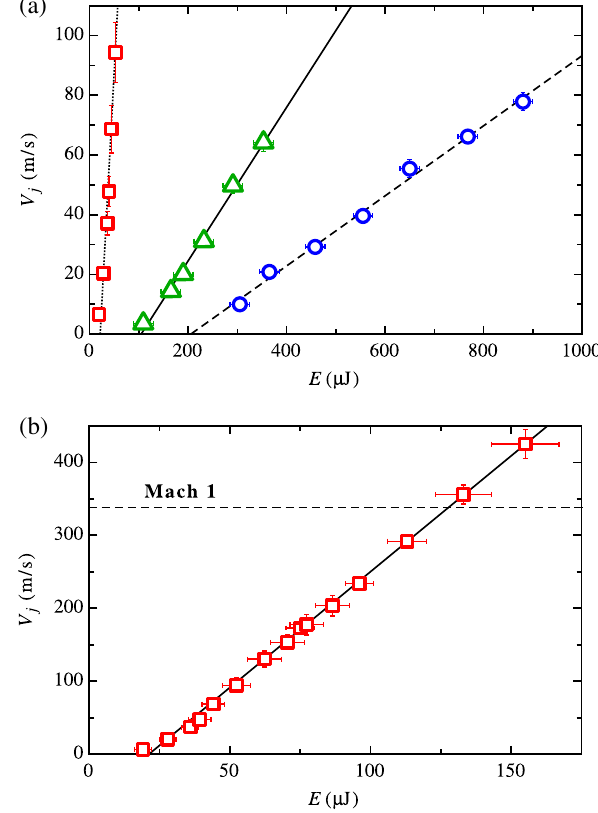
FIG. 8. (a) Asymptotic jet velocity V as a function of the j energy absorbed by the liquid in the capillary tubes. The squares ( h ), triangles ( 4 ) and circles ( (cid:7) ) represent the data for capillary tubes with 50 - (cid:1) m , 200 - (cid:1) m , and 500 - (cid:1) m inner diameters, respectively. Each data point is the result of at least three measurements. The lines are linear fits to the data. (b) The data for the 50 - (cid:1) m diameter tube are shown on an expanded scale. Each data point is the result of at least five measurements. The linear dependence on the energy is seen to hold also for supersonic